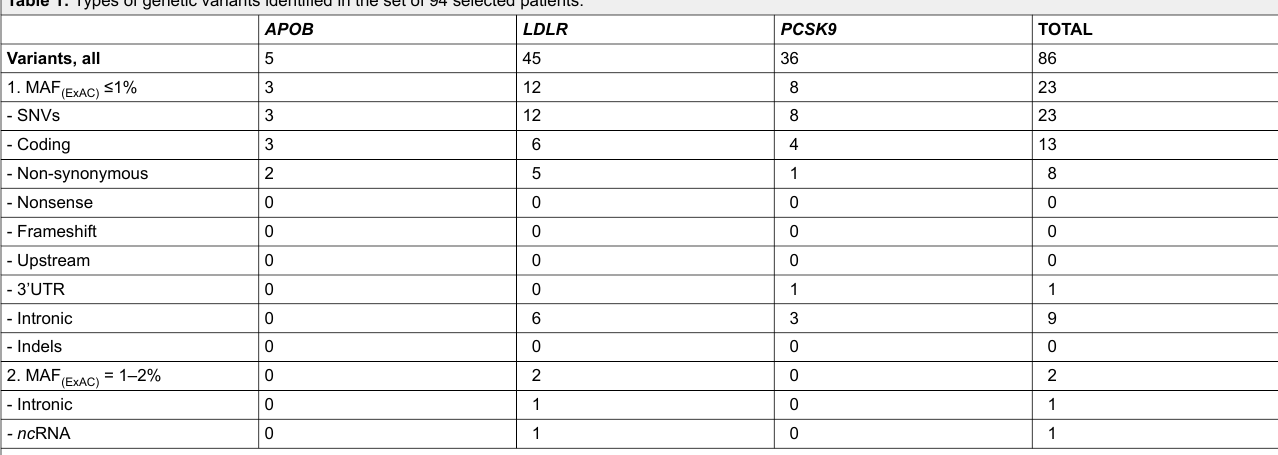
Table 1: Types of genetic variants identified in the set of 94 selected patients. APOB LDLR PCSK9 TOTAL Variants, all